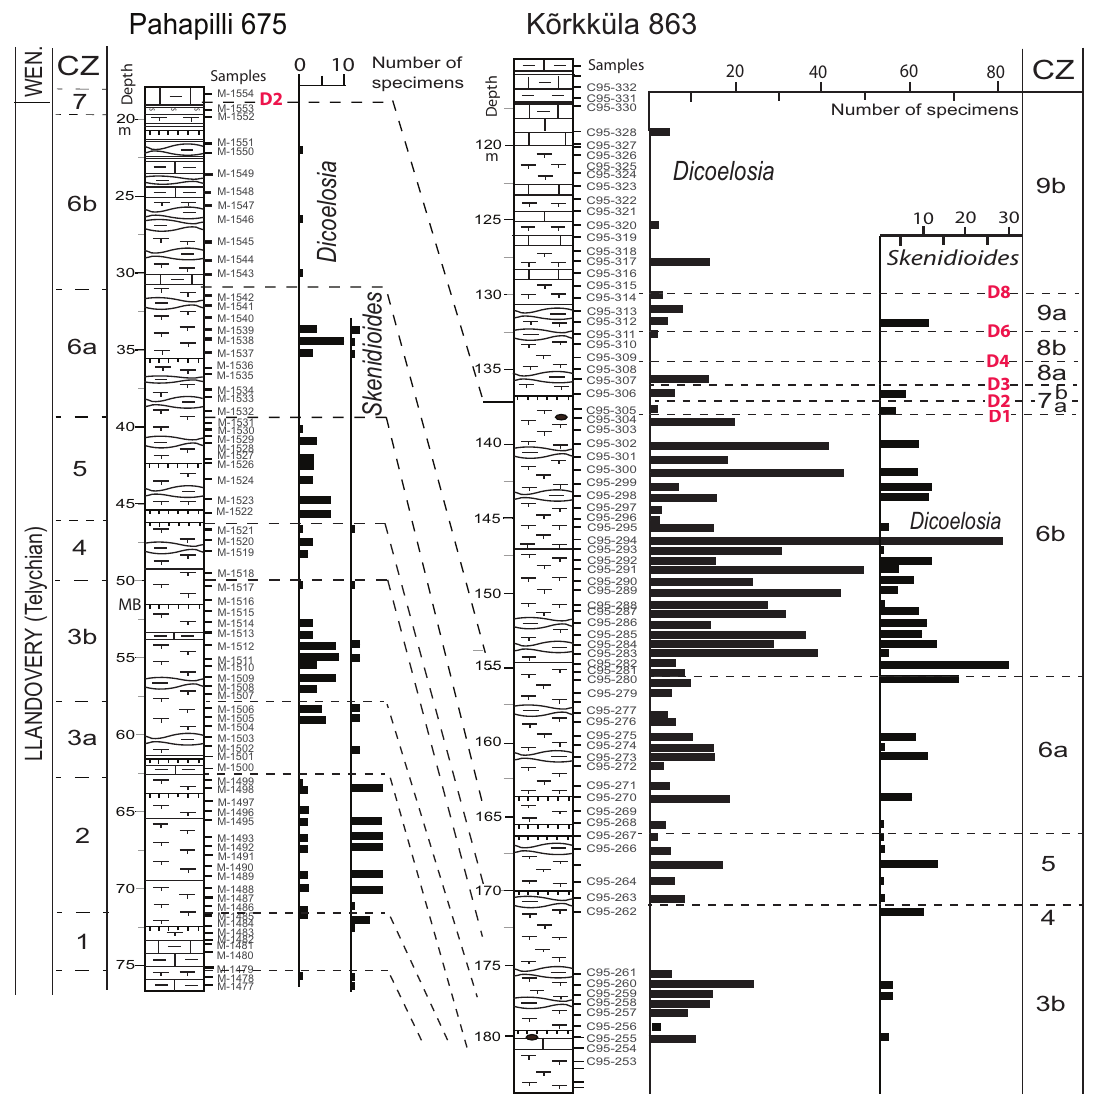
Fig. 3 . Distribution and number of specimens of brachiopods Dicoeloidea and Skenidioides in the Pahapilli 675 and Kõrkküla 863 sections. For the legend and explanation of indexes, see Figs 1 and 2. To the right of the logs are the primary sample numbers by P. Männik (samples from the Pahapilli section are marked with “M”, samples from Kõrkküla with “C95”). WEN. – Wenlock; CZ – Conodont biozones; D1–D8 – Datum planes of the Ireviken